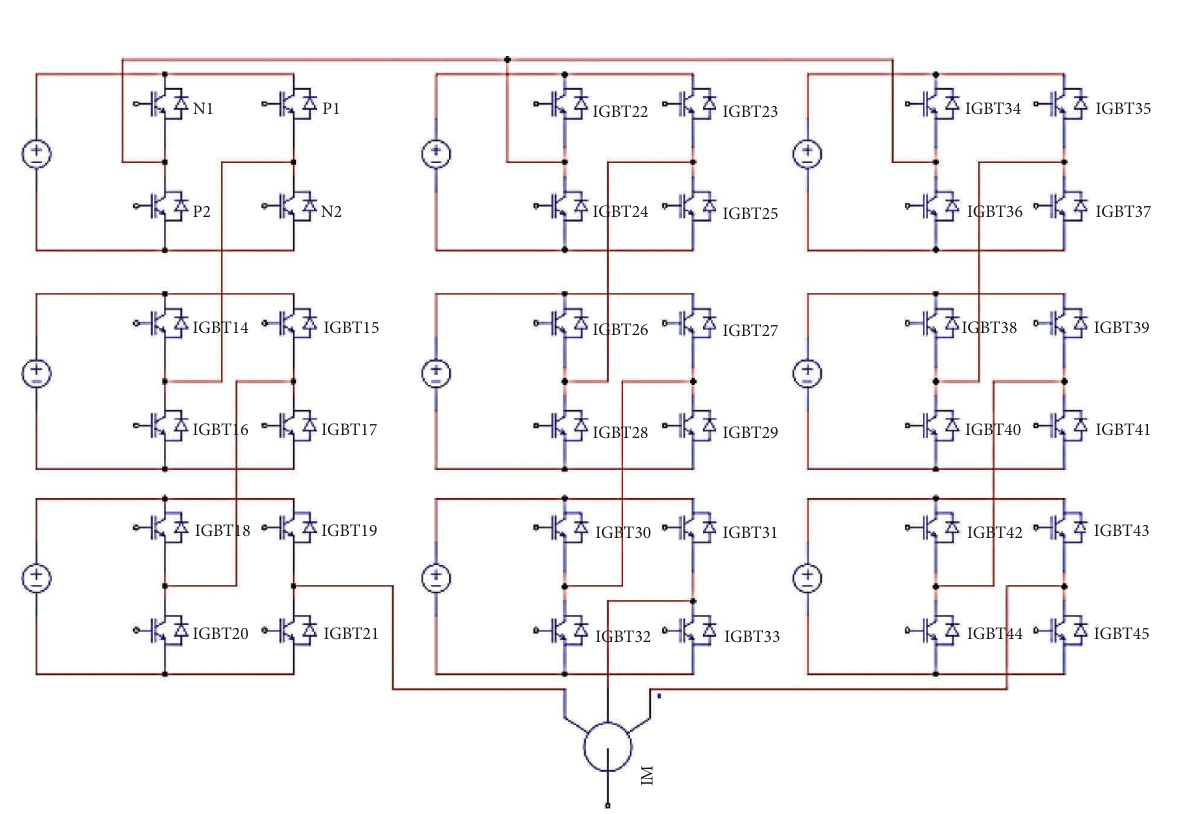
Figure 5: Cascaded H-bridge of seven-level inverter fed induction motor